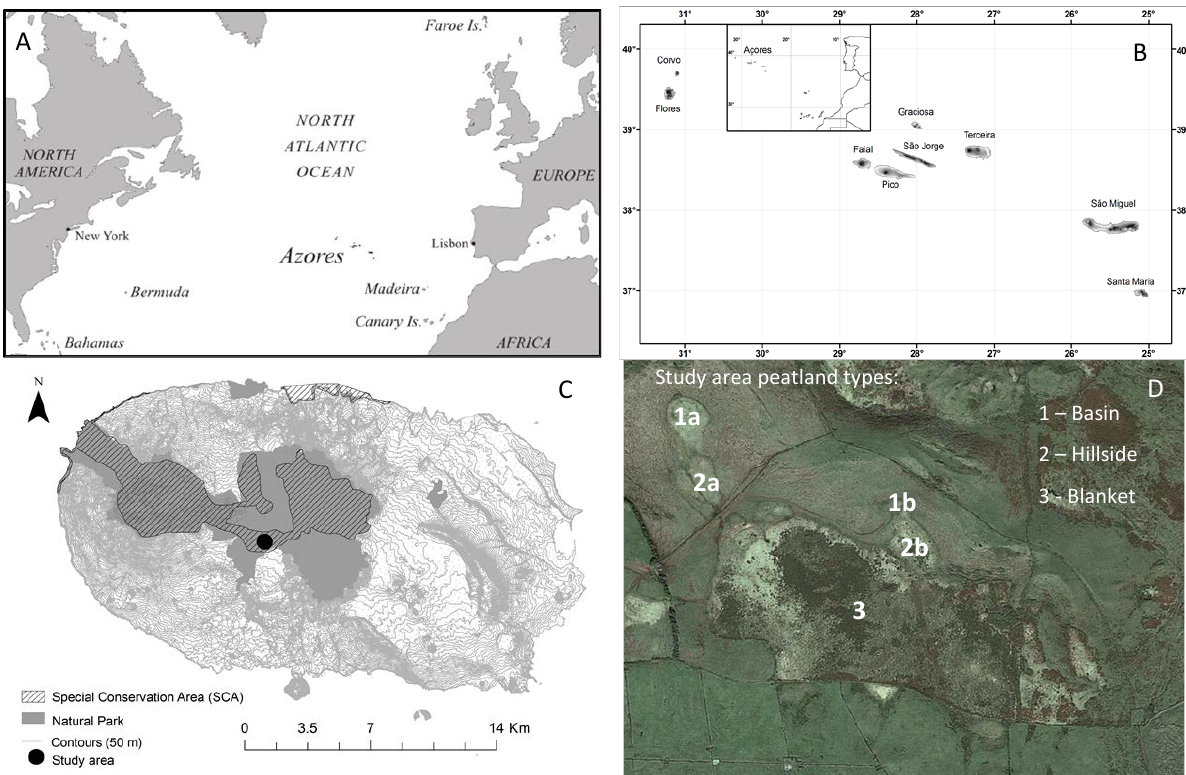
Figure 1. A: map of the North Atlantic region, showing the location of the Azores archipelago; B: map of the Azores archipelago; C: map of Terceira Island identifying the study area inside the Special Conservation Area (SCA) and Natural Park; D: aerial image of the Criação de Filipe peatland complex, distinguishing different peatland types (1, 2 and 3). Aerial photo by Google Earth, 2011.